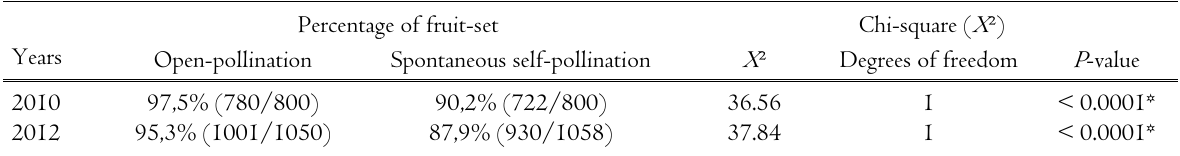
T ABLE 3. Comparison between the percentage of fruit tomato crops in São José de Ubá, in 2010 and 2012. Values difference between tests in each area ( P <0.05)